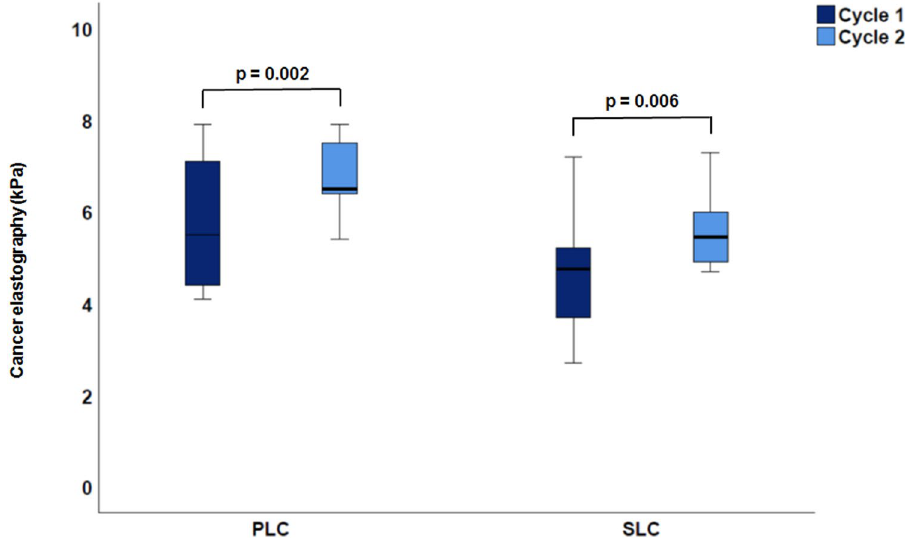
Figure 4. Comparison of elastography in both groups with increasing stiffness from the first to the second cycle (PLC: p = 0.002; SLC: p = 0.006).